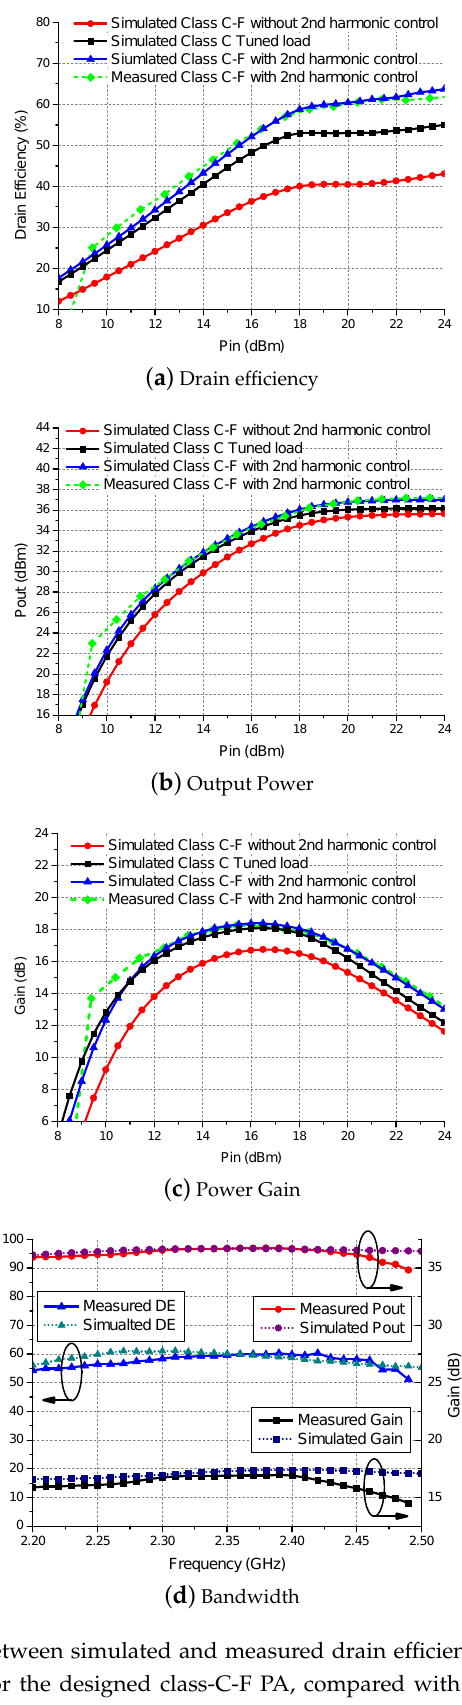
Figure 12. Comparison between simulated and measured drain efficiency (DE) ( a ), output power ( b ), and power gain ( c ) for the designed class-C-F PA, compared with tuned load and improper harmonic control results. Measurement performances over frequency for a fixed input power level of P in = 18.4 dBm are reported in ( d